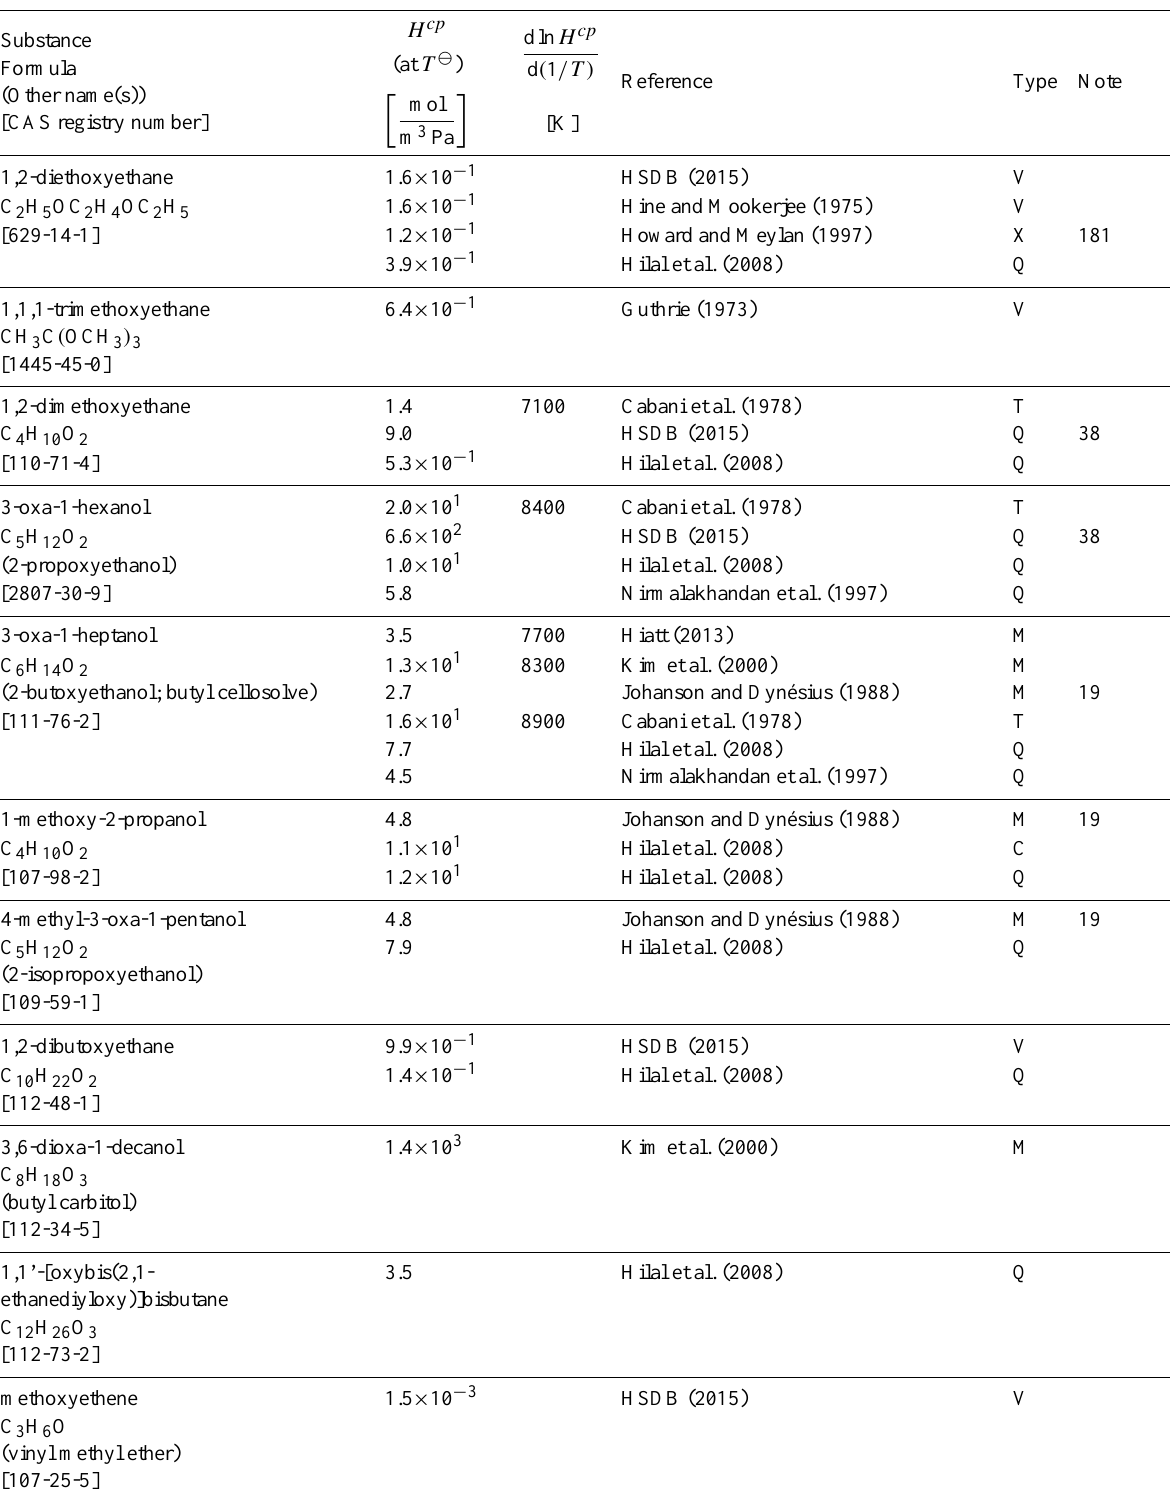
Table 6: Henry’s law constants for water as solvent